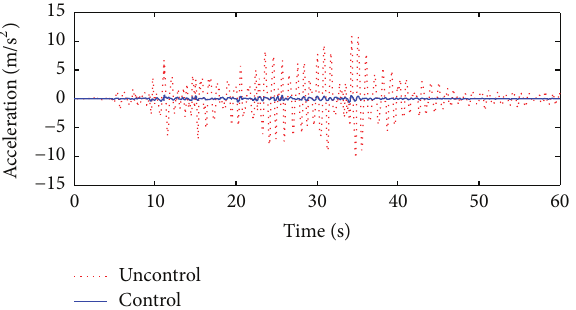
Figure 13: Displacement of all five floors for uncontrolled and syn- chronized control coupled with 𝐻 2 / LQG algorithm in Bam Earth- quake.